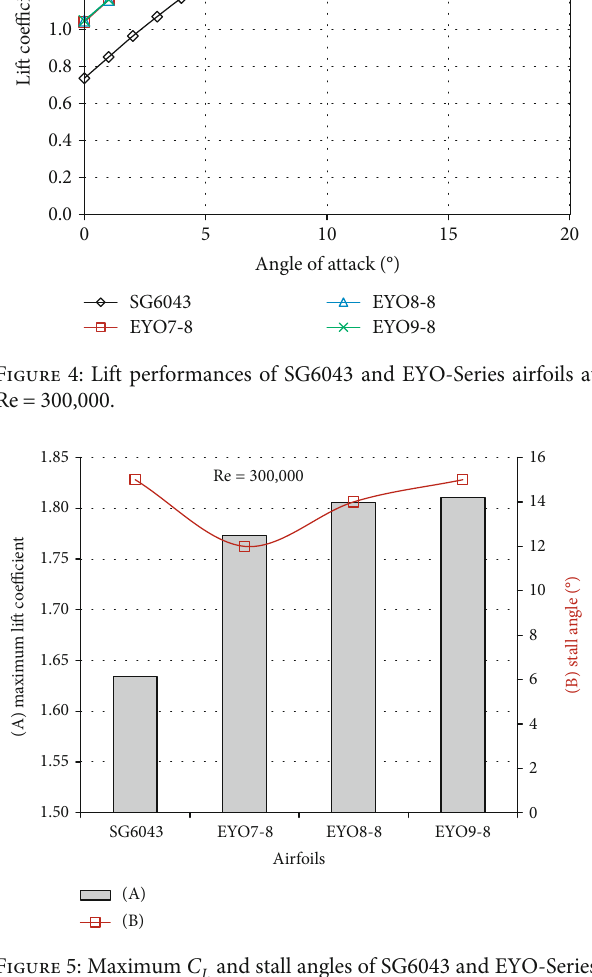
Figure 5: Maximum C L and stall angles of SG6043 and EYO-Series airfoils at Re = 300,000 .